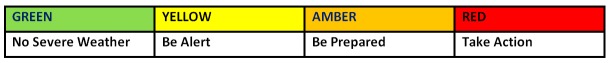
Adapted from http://www.metoffice.gov.uk/guide/weather/warnings